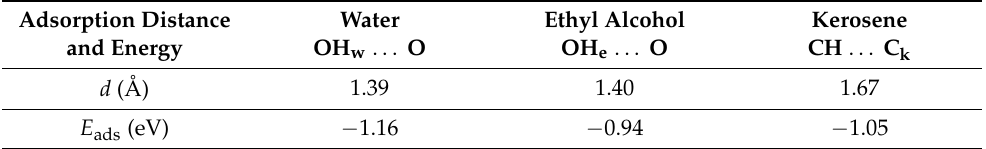
Table 1. Adsorption distance and adsorption energy for water, ethanol, and kerosene on hemicel- lulose.